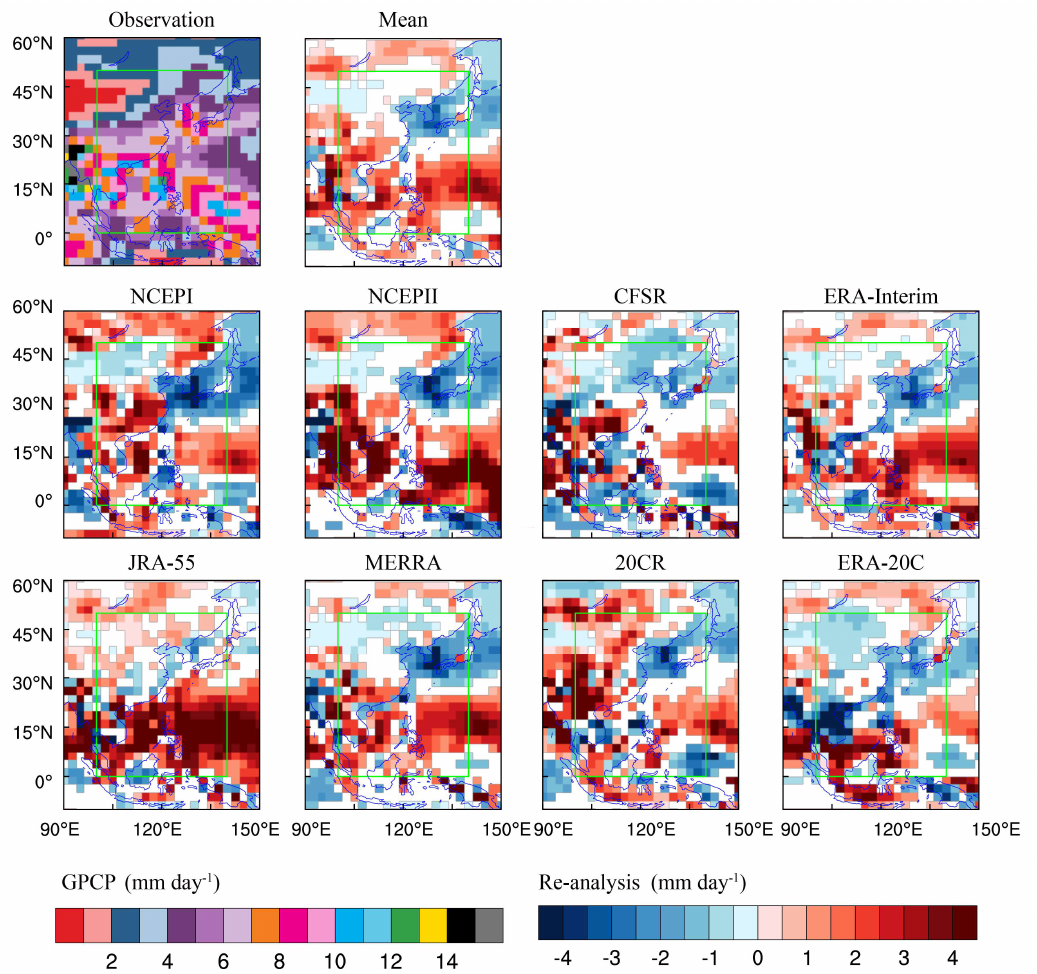
Figure 4. Summer (JJA) precipitation of the Global Precipitation Climatology Project (GPCP) and the precipitation anomalies ‘re-analysis minus GPCP’ in 1979–2010. The presented anomalies of the precipitation pass Student’s t -test at 0.05 level. The green box represents the East Asian summer monsoon region (0–50° N, 100–140° E).